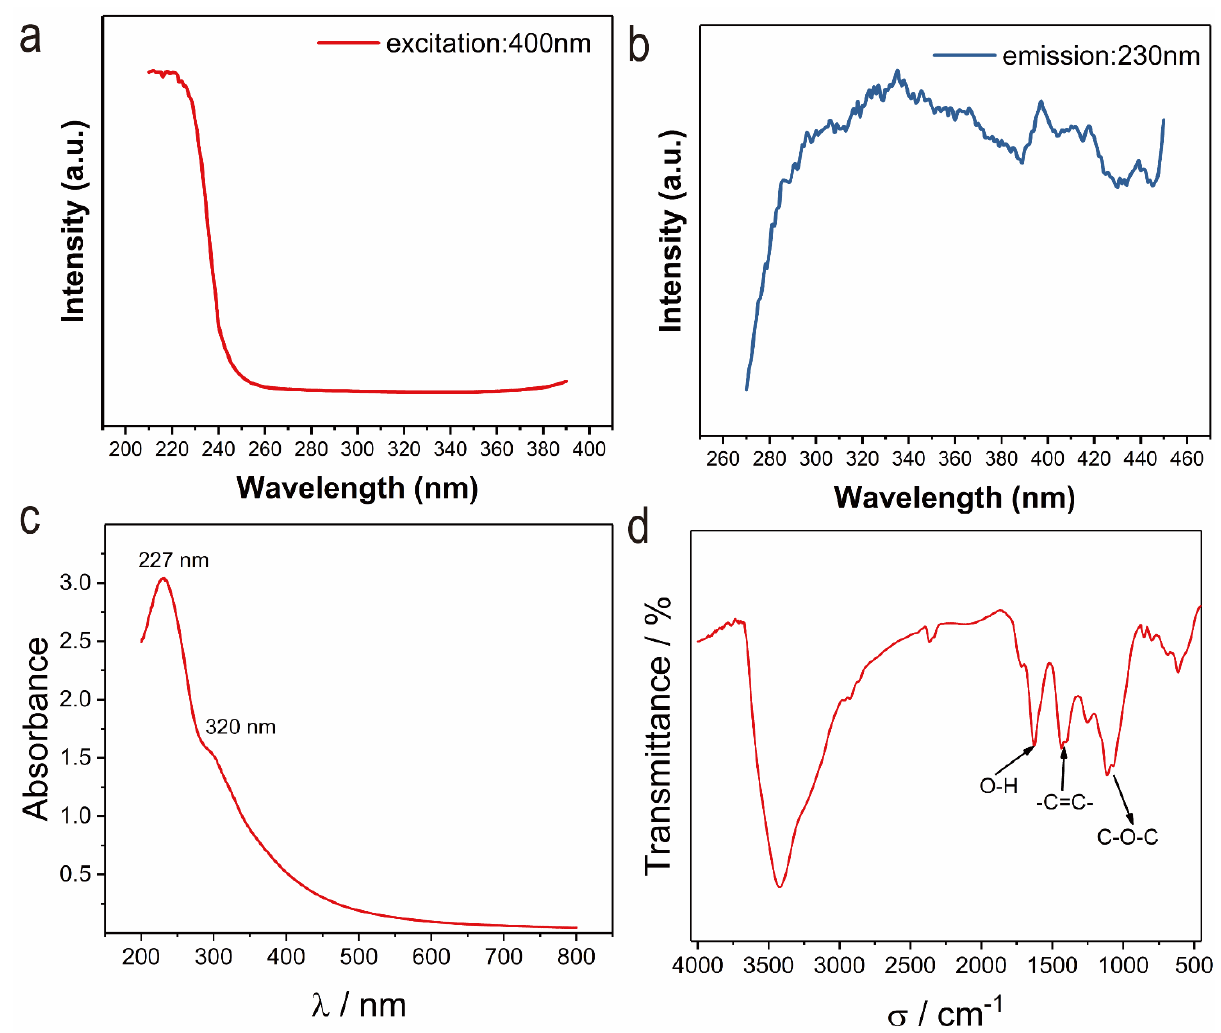
Figure 5. ( a , b ) Excitation (Ex: 400 nm) and emission (Em: 230 nm) spectra of rGO. ( c ) UV-Vis absorption spectrum of rGO. ( d ) FTIR spectra of rGO.